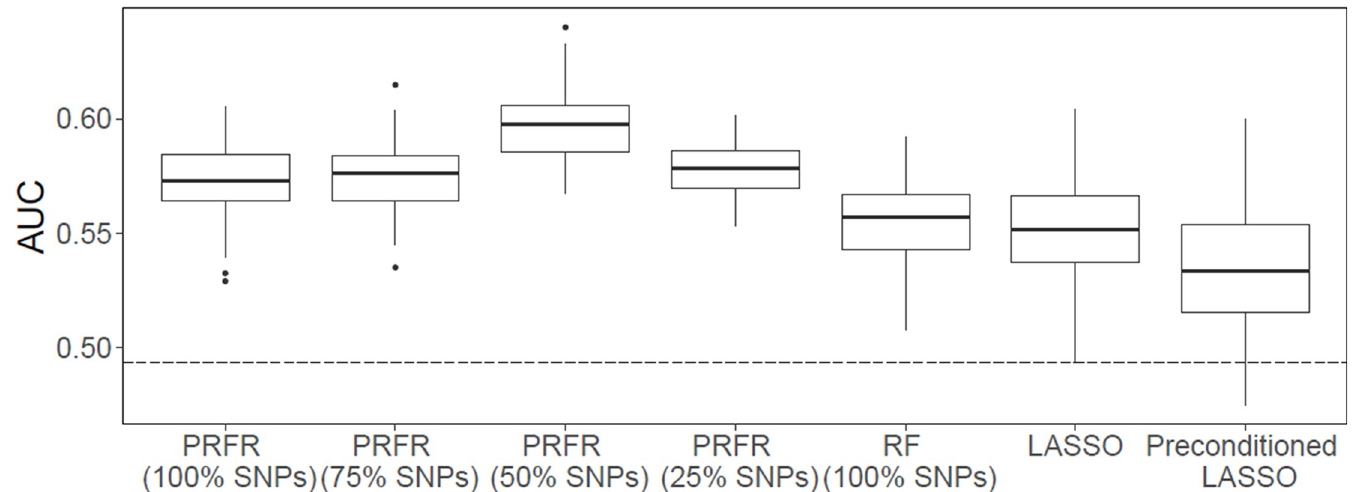
Fig 3. Comparison of prediction areas under the curve (AUCs) on the hold-out validation dataset between different multivariate radiation-associated contralateral breast cancer models. Each box plot indicates the fluctuation of AUCs over 100 iterations of 5-fold cross validation. Abbreviations : LASSO—least absolute shrinkage and selection operator; PRFR—preconditioned random forest regression; RF—random forest; SNPs—single nucleotide polymorphisms. The dotted line indicates the prediction AUC when the first 3 principal components for ancestry were used as the only